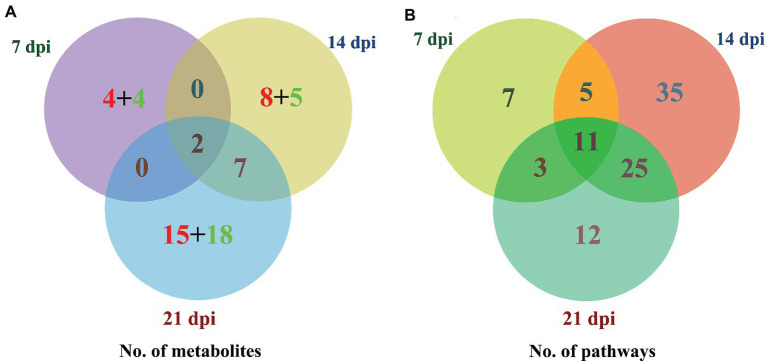
Three-way Venn diagrams of the (A) differentially abundant metabolites and (B) enriched metabolic pathways at 7, 14, and 21 dpi. The time after infection is indicated next to the corresponding circle. The numbers of metabolites shared between the groups are indicated at the intersections of the circles in the Venn diagram. The number of metabolites specific to each time point is shown inside the corresponding circle in red + green colors, denoting the upregulated and downregulated metabolites, respectively. Two SAMs and 11 enriched metabolic pathways were shared in common between all groups at the three time points after infection.